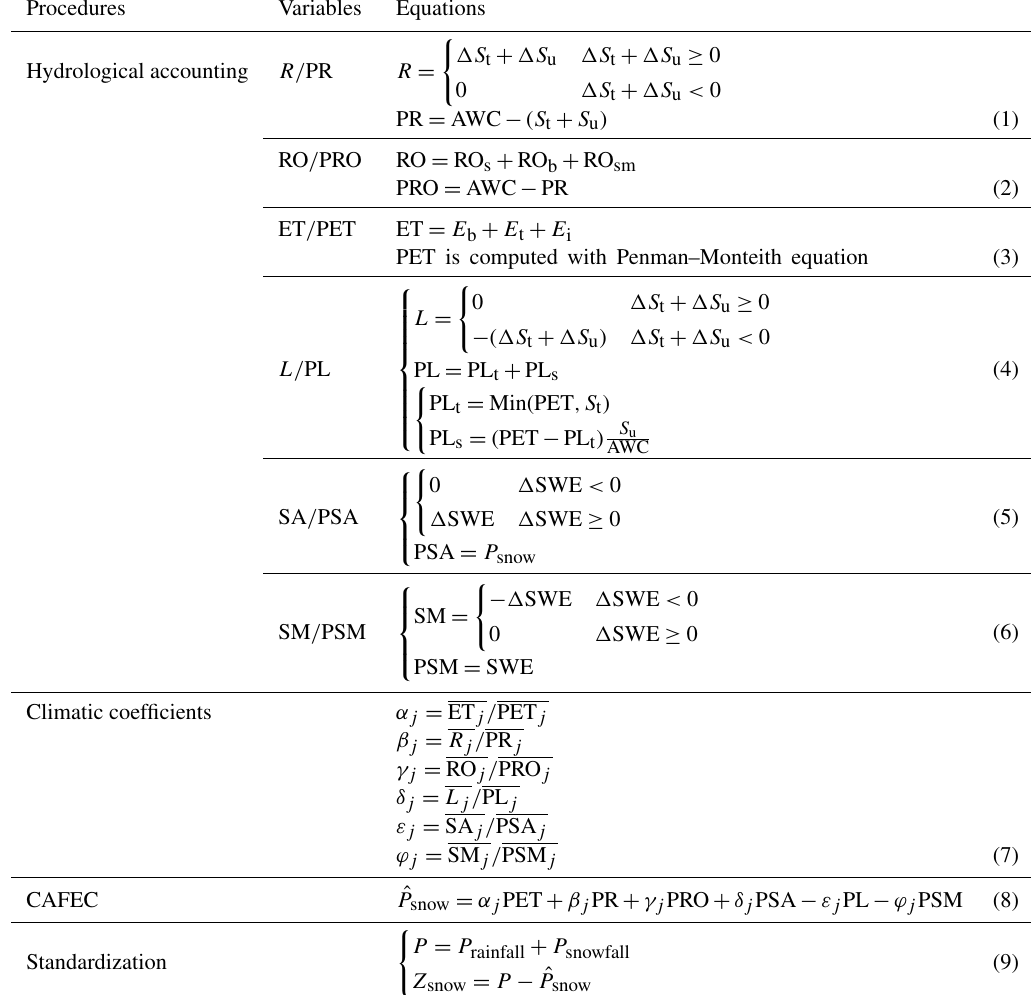
Table 1. The procedures, variables, and associated equations used to calculate the SZI snow . Procedures